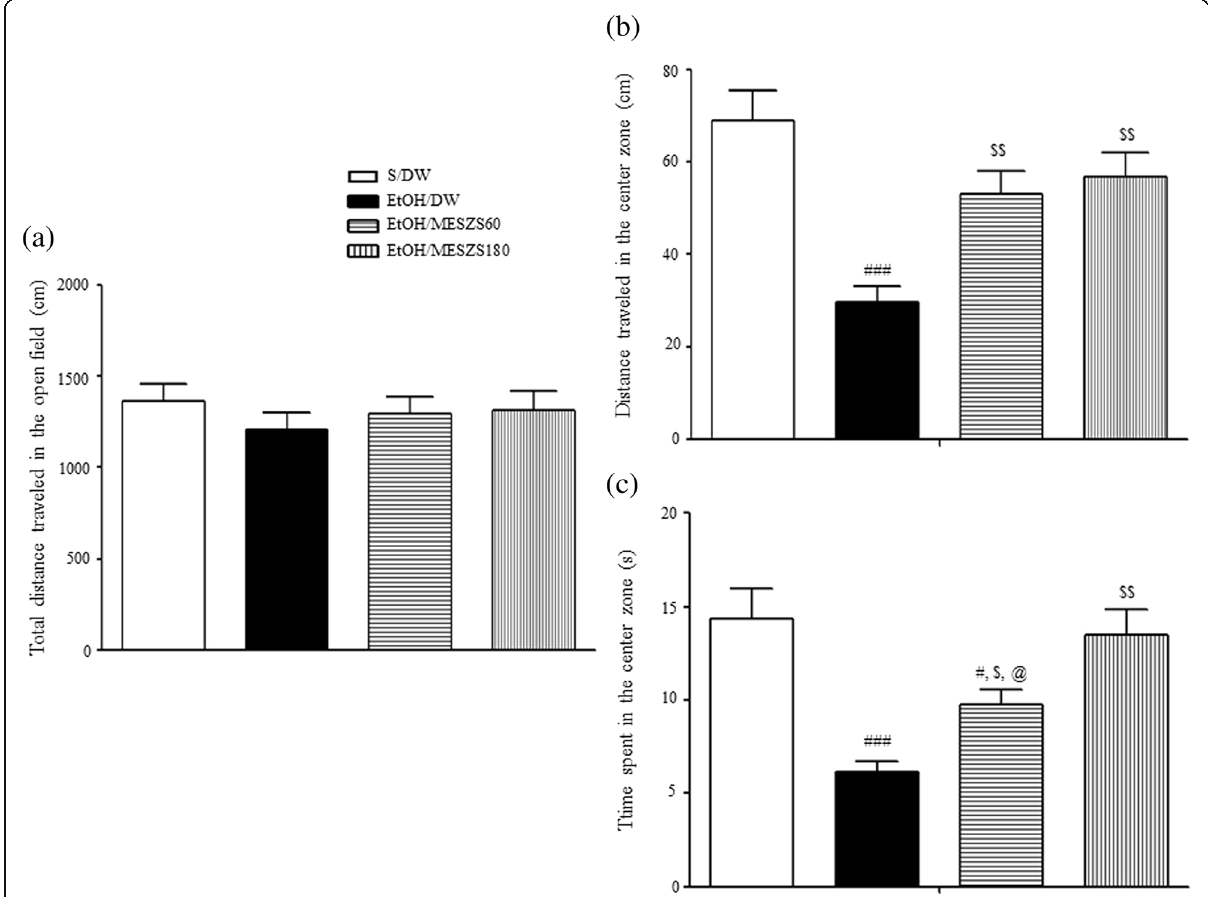
Fig. 2 Effects of MESZS on the behavioral changes of rats in the open field test. All data are expressed as a mean ± SEM ( n = 8). ( a ) The total distance traveled in the open field by rats. ( b ) Distance traveled in the center zone. ( c ) Time spent in the center zone. S: saline, DW: distilled water, MESZS: methanol extract of Semen Ziziphi Spinosae , MESZS60: 60 mg/kg/d MESZS, MESZS180: 180 mg/kg/d MESZS. # p < 0.05 and ### p < 0.001 vs. S/DW group; $ p < 0.05 and $$ p < 0.01 vs. EtOH/DW group; @ p < 0.05 vs. EtOH/MESZS180 group (one-way ANOVA followed